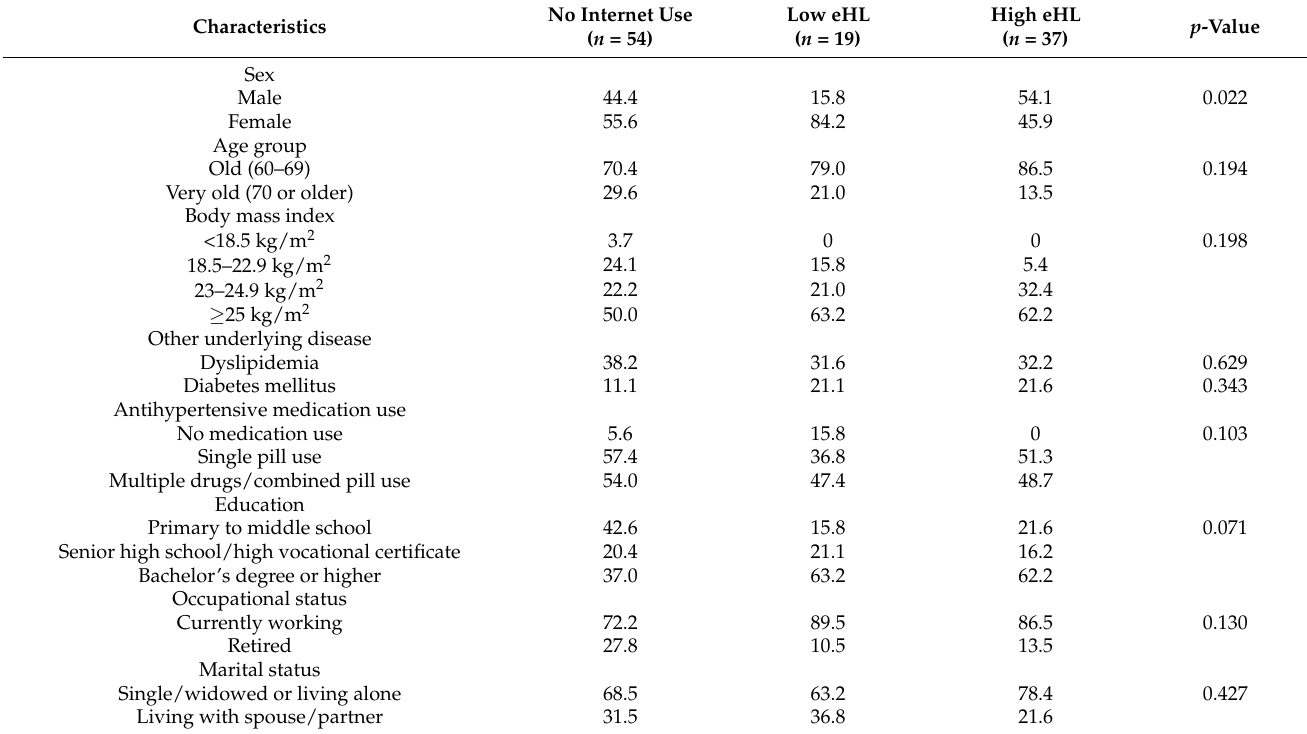
Table 3. Factors associated with electronic health literacy ( n =